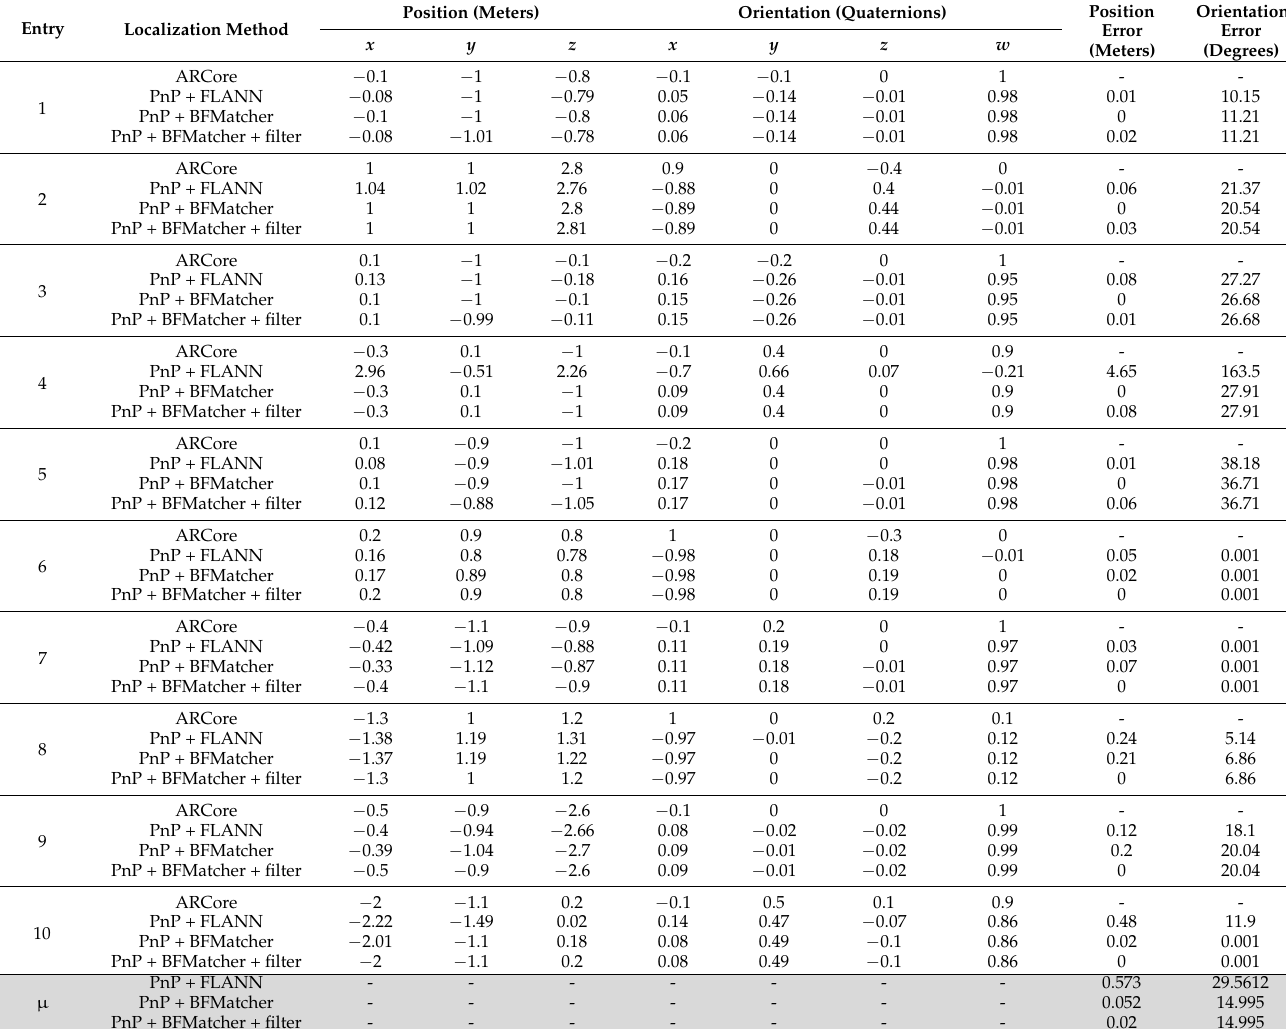
Table 2. Differences between ground truth, provided by ARCore, and estimated positions and orientations, obtained by running the PnP algorithm with FLANN, respectively with BFMatcher, with and without filtering. Entry Localization